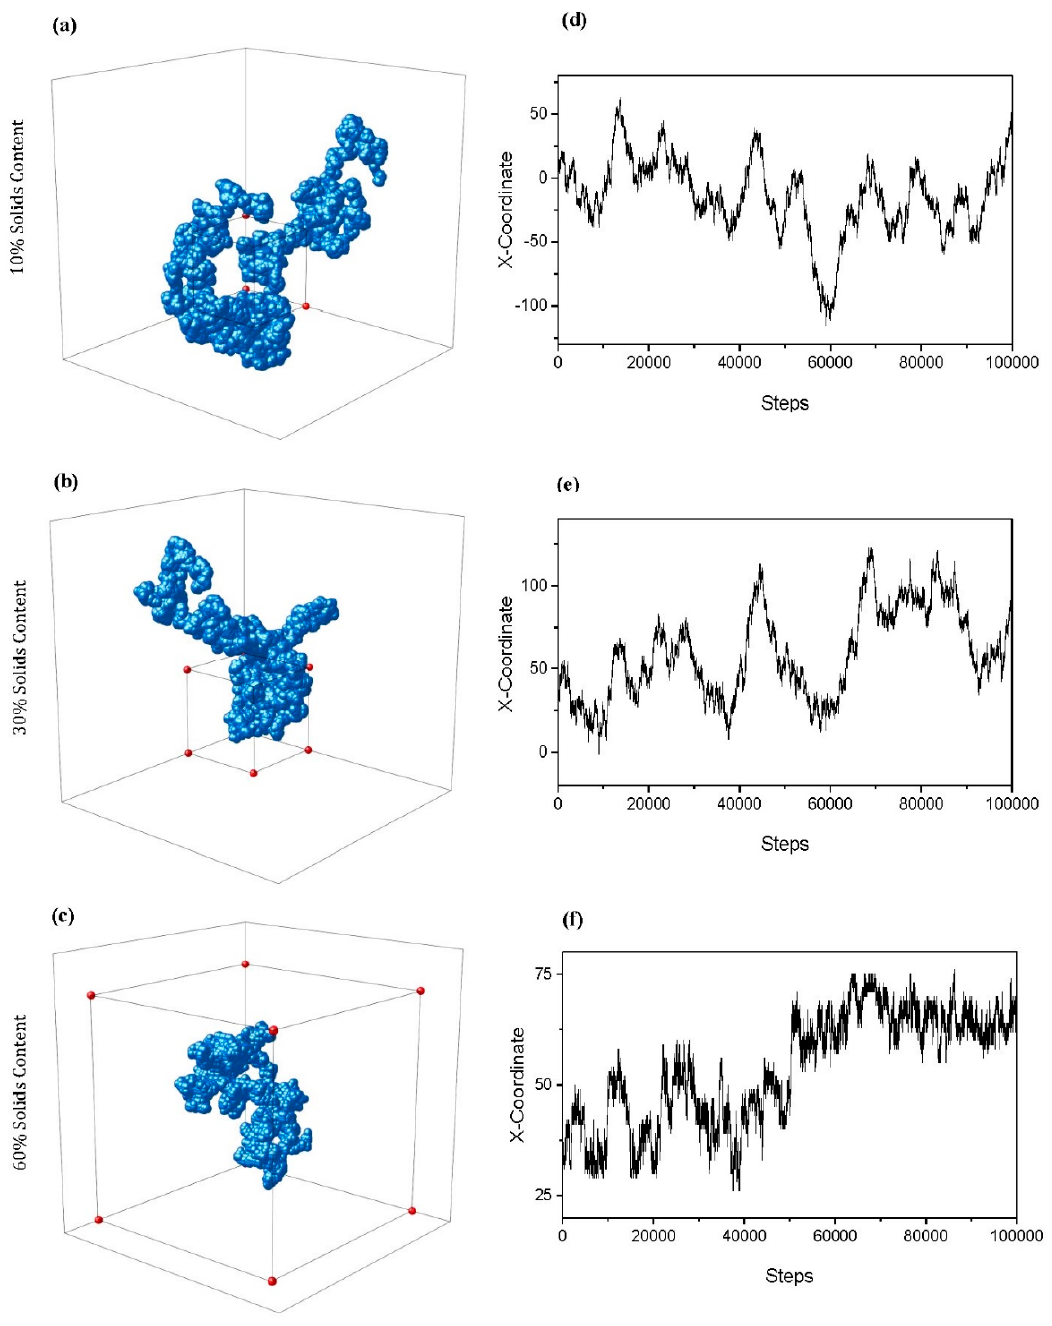
Figure 8. Example 3D traces for particles of three sites in size diffusing through simulated structures with 1% activated monomers ( C c ) and solids content ( S c ) values of ( a ) 10%, ( b ) 30%, and ( c ) 60%. Note that the axes of each trace differ dependent on the extent to which the particle was able to diffuse through the lattice across periodic boundaries—a box of size 100 × 100 × 100 sites is included within each trace to allow a comparison of scale. Corresponding x coordinate traces for each structure at S c values of ( d ) 10%, ( e ) 30%, and ( f ) 60%.